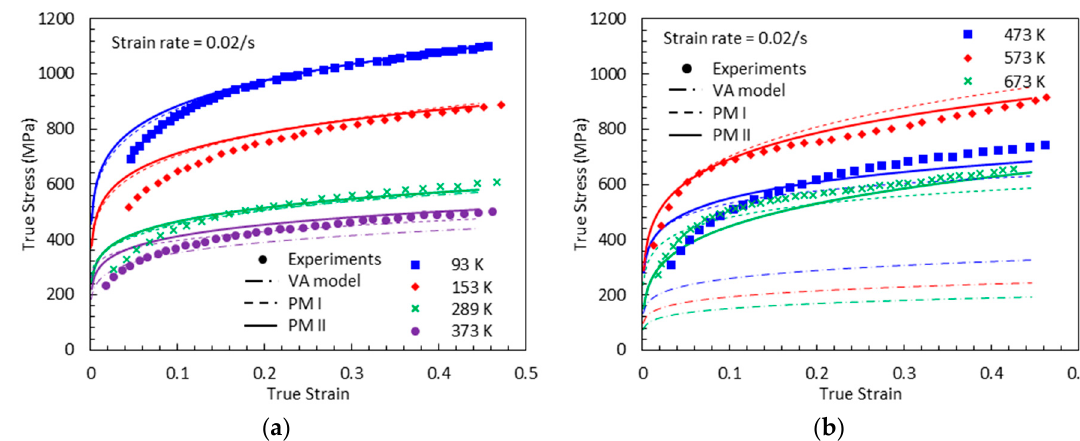
Figure 20. True stress-true strain curves from experimental measurement [1], predictions by the VA model, PM I, and PM II with (cid:2013)(cid:4662) = 0.02 s − 1 : ( a ) T = 93, 153, 289 and 373 K ( b ) T = 473, 573 and 673 K